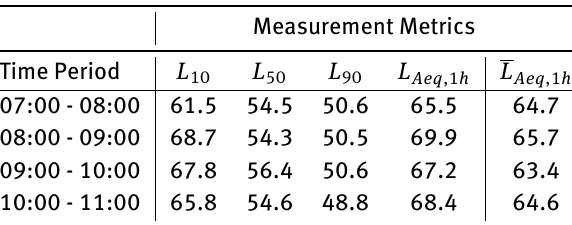
Table 1: Noise metrics obtained from measurements. ˜ L Aeq ,1 h refers to event filtered sound pressure levels.